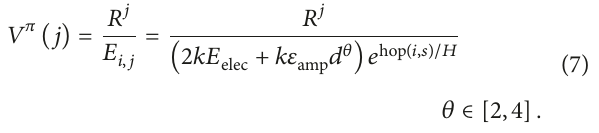
Figure 4 is the flow chart of the QLSORP